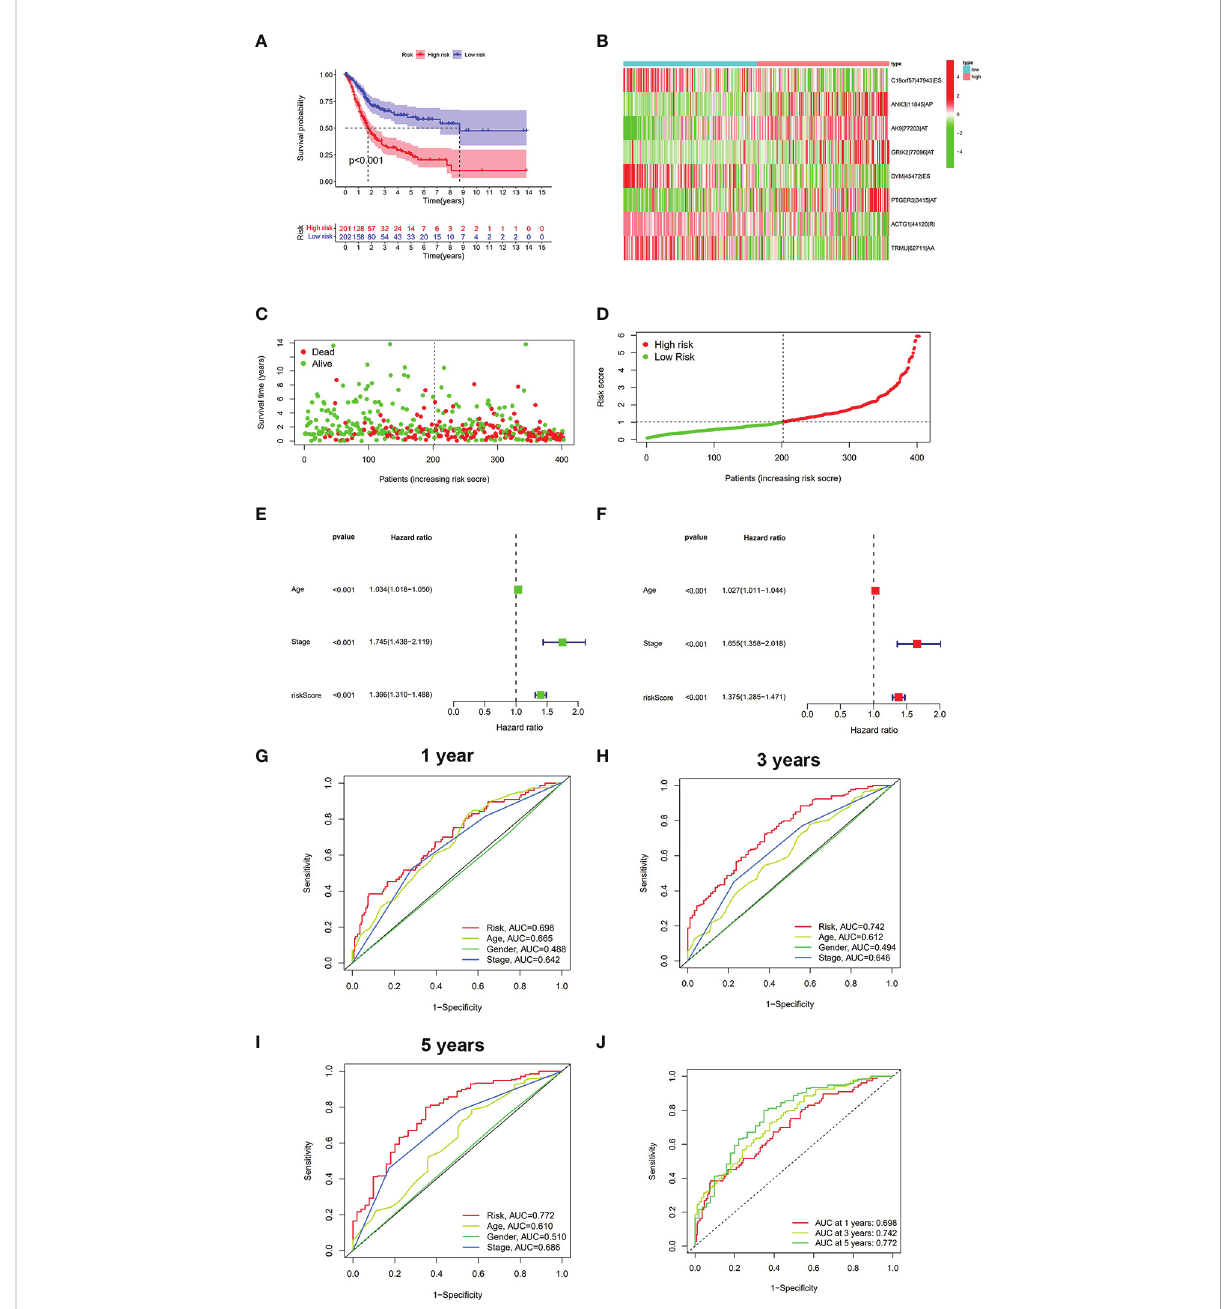
FIGURE 2 The analysis of risk score model in BLCA. (A) Kaplan – Meier survival analysis of OS between the low-risk group and the high-risk group. (B) Heatmap of eight prognostic AS events between the low-risk group and the high-risk group. (C) Survival state diagram of BLCA; green dots represent survival, and red dots represent death. (D) The distribution of risk score among BLCA patients. (E) Univariate analysis of risk score and other clinical parameters. (F) Multivariate analysis of risk score and other clinical parameters. (G) ROC curve of risk score and other clinical parameters at 1 year. (H) ROC curve of risk score and other clinical parameters at 3 years. (I) ROC curve of risk score and other clinical parameters at 5 years. (J) ROC curve of risk score at 1, 3, and 5 years. BLCA, bladder cancer; OS, overall survival; ROC, receiver operating